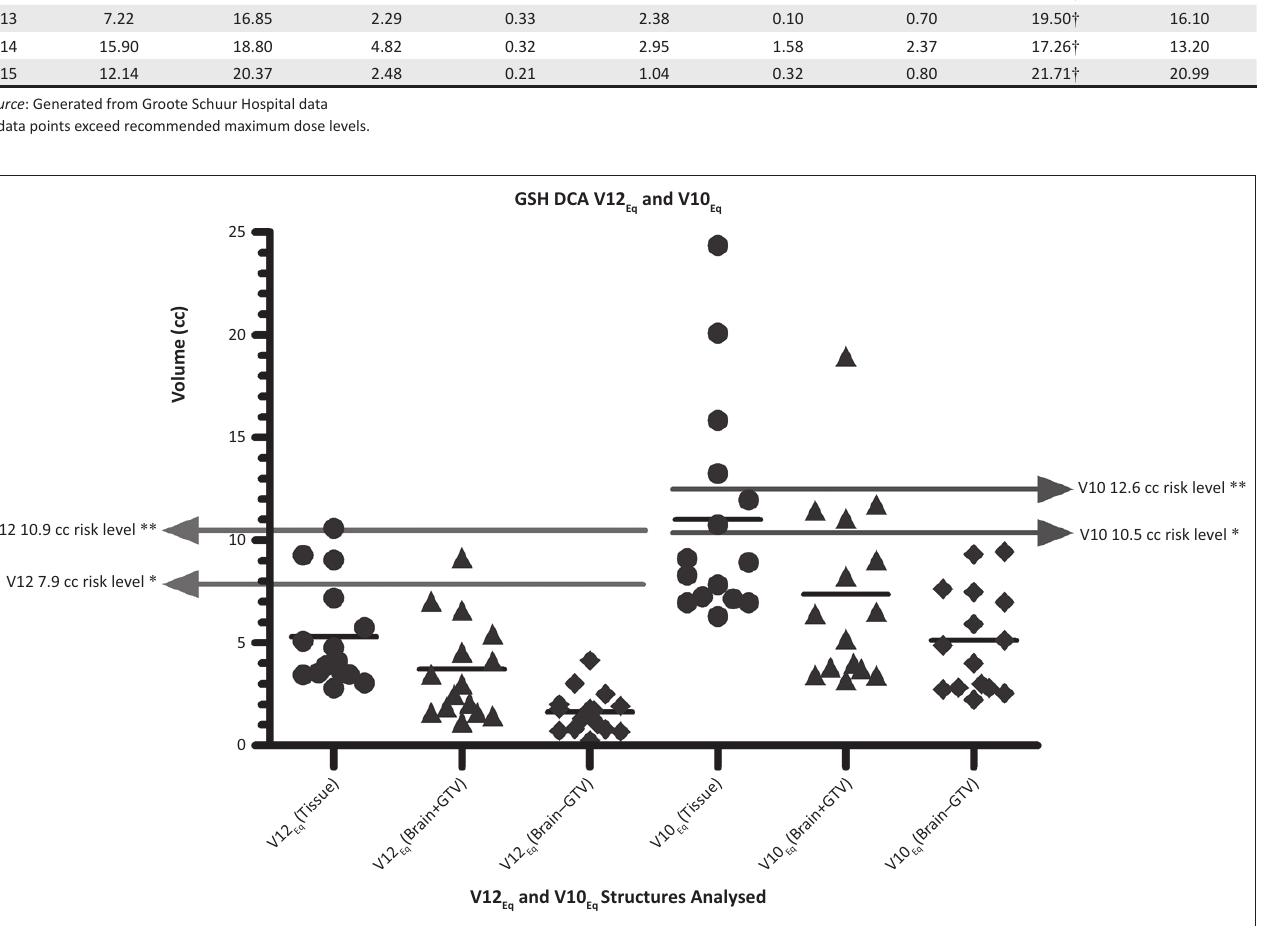
and 10 Gy . Eq Eq